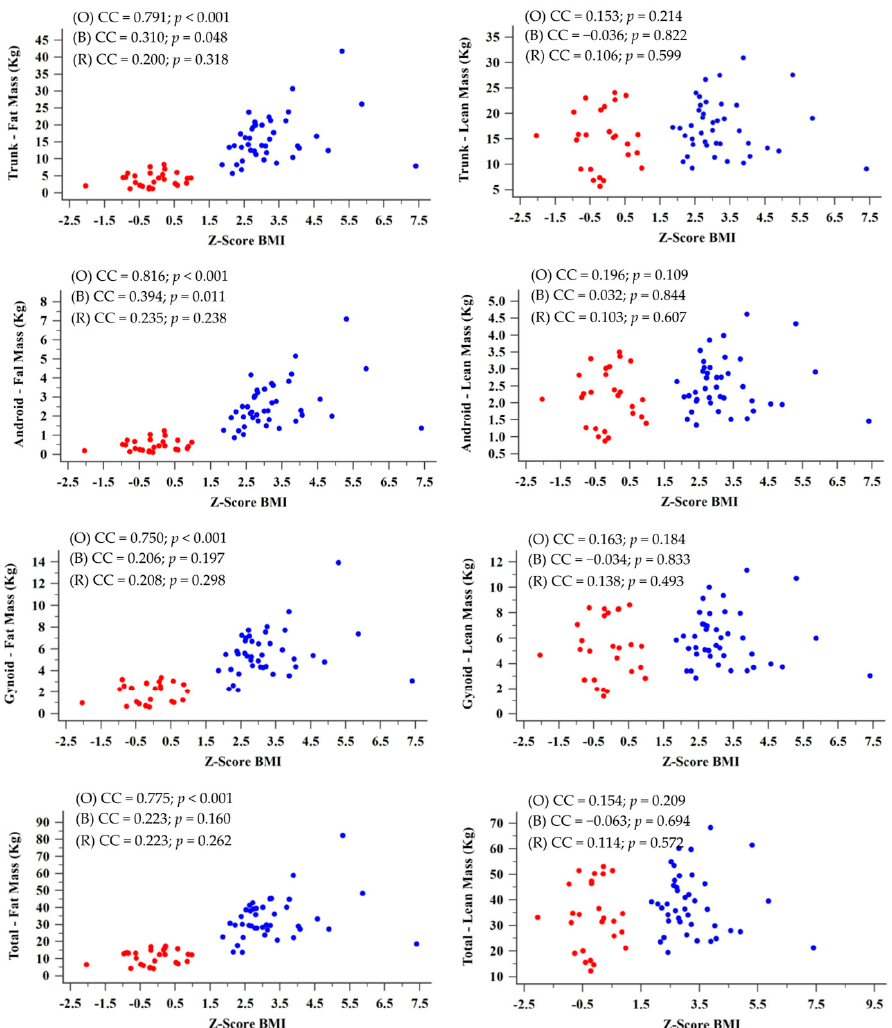
Figure 2. Correlation between the body mass index (BMI) z-score and the variables of fat mass and lean body mass. Blue (B) indicates participants with obesity, and red (R) indicates participants without obesity (control group). CC, correlation coefficient. The statistical analyses were carried out based on Spearman’s rank correlation coefficient. Alpha = 0.05.